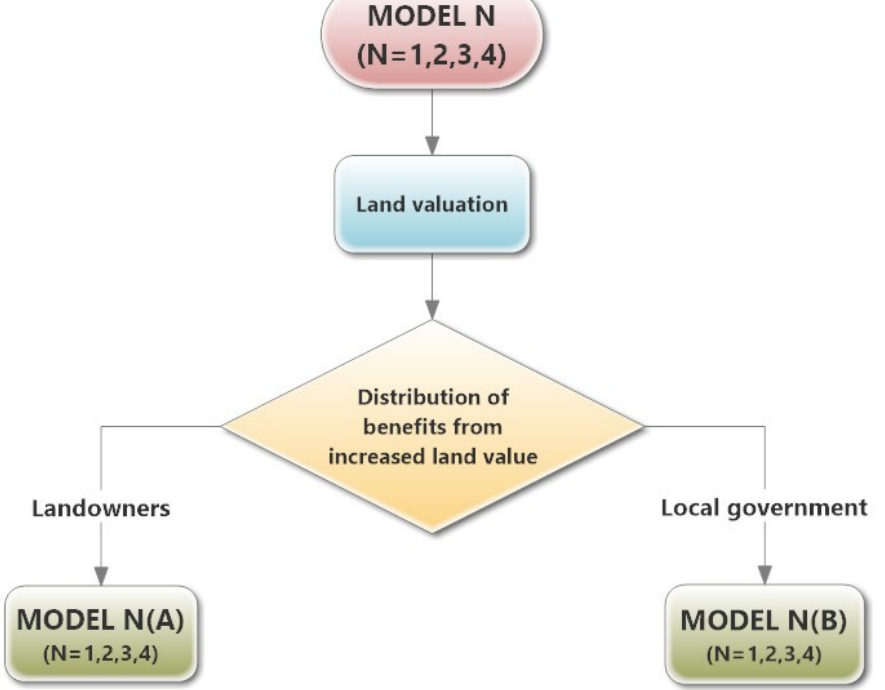
Figure 2. Flow chart of LR process depending on distribution of benefits from increased land value.